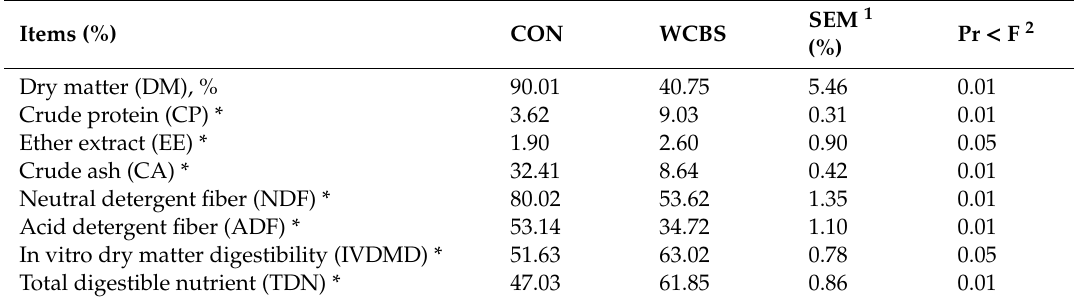
Table 2. Nutrient compositions of the control and whole-crop barley silage